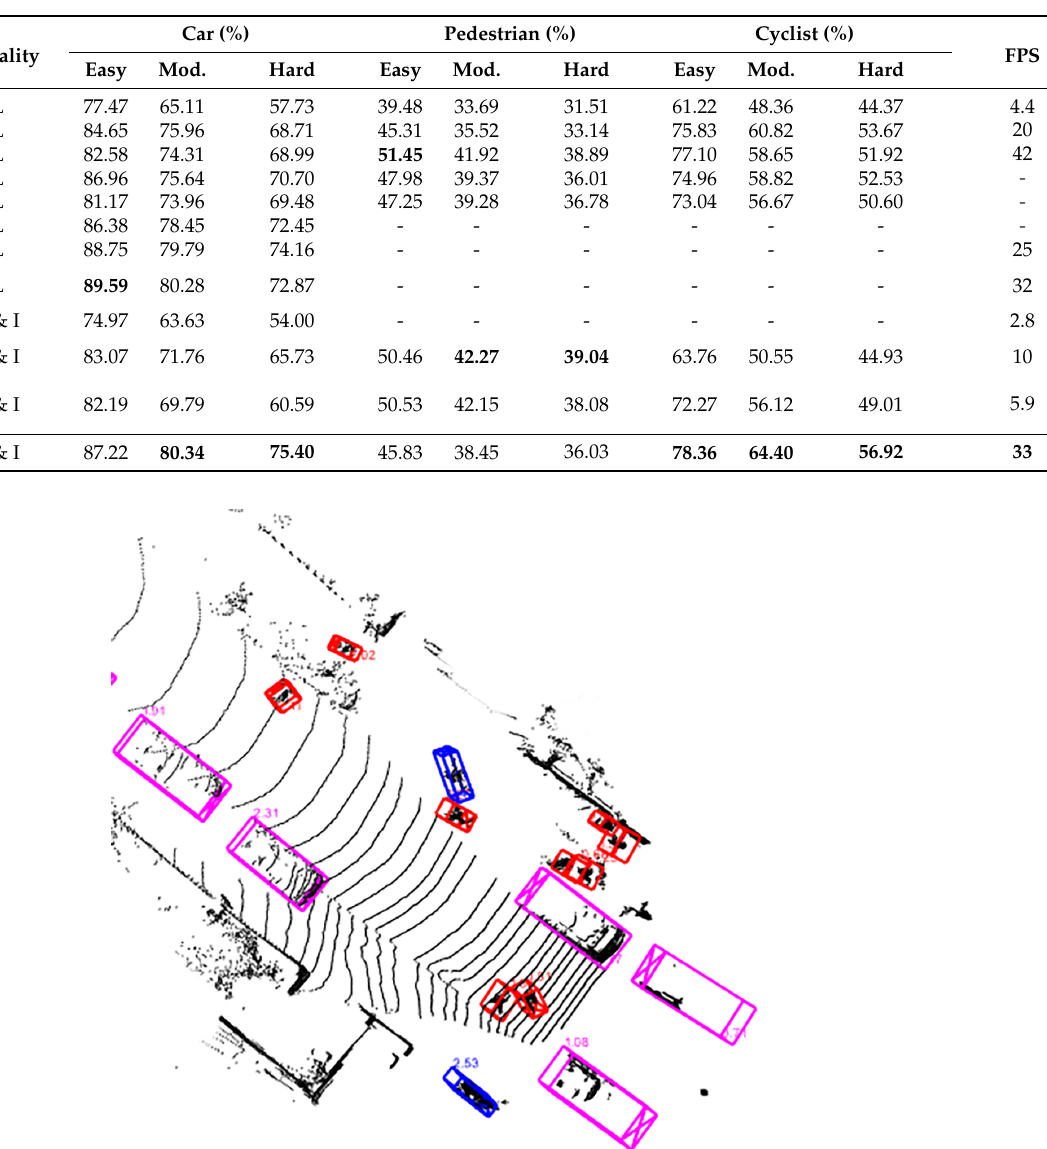
Table 4. The 3D detection AP of compared methods on the KITTI test data. The modalities include lidar (L) and images (I). The CLOCs_SecCas is short for the approach of SECOND+Cascaded R-CNN.